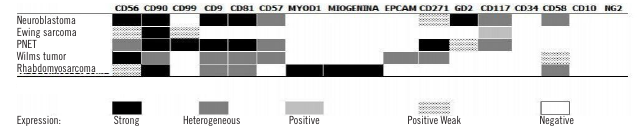
FIGURE 2 – Immunophenotypic markers PNET: primitive neuroectodermal